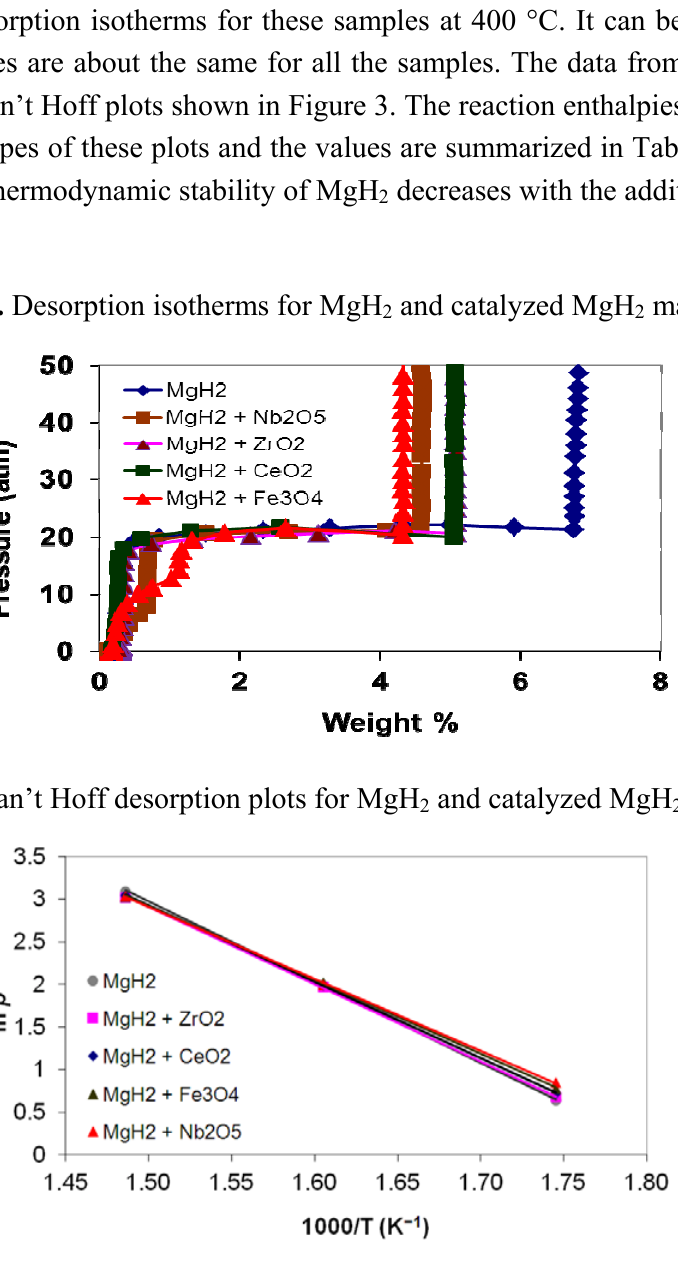
Figure 2. Desorption isotherms for MgH